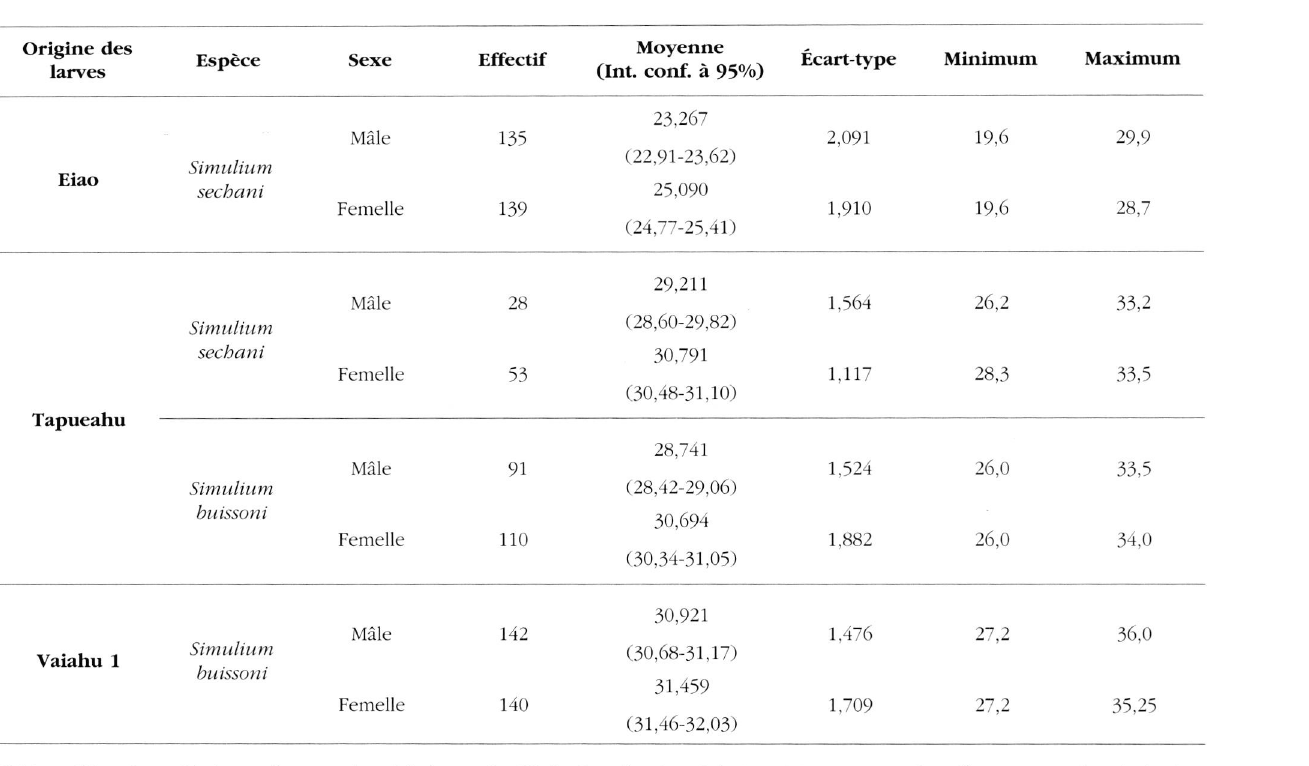
Origine des larves